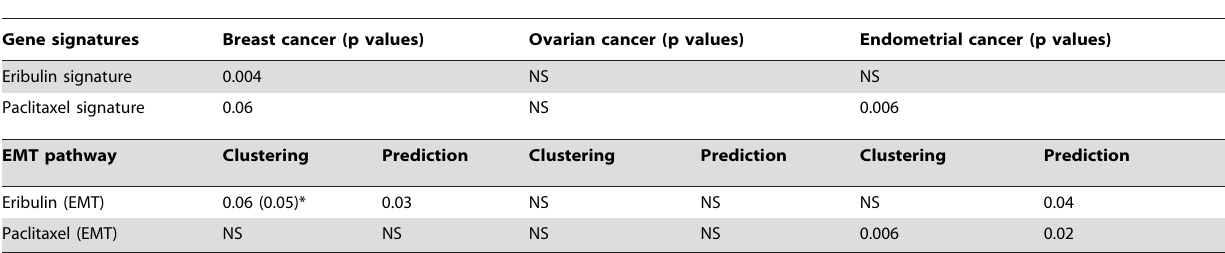
Table 1. Correlation of gene signatures with in vitro antiproliferative data.